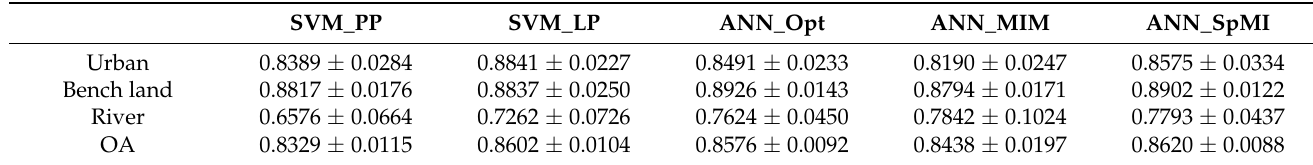
Table 16 indicates the objective indicators of three ANN-based classifiers and two SVM classifiers on different forms of parameters of Touzi decomposition for the Xian area. For the pixels in Urban regions, the correct rate of proposed SVM_LP is approximately 5% higher than that of SVM_PP. For the three ANN-based classifiers, the accuracy of ANN_SpMI reaches 85.8%, which is a little higher than that of different optimization parameters of ANN_Opt and even 4% higher than that of similar classification process of ANN_MIM. The classification accuracy of five classifiers is approximately the same for the Bench land. The ANN_Opt is the highest and the correct rate is 89.2%, while that of the proposed ANN_SpMI is only 0.2% difference from the best. Furthermore, the classification accuracy of SVM_LP is slightly higher than that of SVM_PP. For the classification of River, the correct rate of SVM_PP is merely 65.8%; this is not a satisfactory classification result. Although the classification result of the proposed SVM_LP for River is 7% larger than that of the former, it is not the best among the five classifiers. Among the three ANN-based classifiers, the accuracy of River of ANN_MIM is the highest and over 78%. However, the standard deviation of the corresponding results is large, and relatively speaking, the classification results are not stable enough. Despite that the accuracy of the proposed ANN_SpMI for River is less than 1% lower than the optimal one, it shows a better stability. From the perspective of OA, SVM_LP and ANN_SpMI are the best among the corresponding comparison classifiers; both are about 86%. In a word, the objective analysis shows that the Touzi parameters obtained by the proposed representation learning scheme indeed have a good classification effect on both classifiers compared with the given comparison algorithms. Table 16. The objective indicators of three ANN-based classifiers and two SVM classifiers on different forms of parameters of Touzi decomposition for the Xian